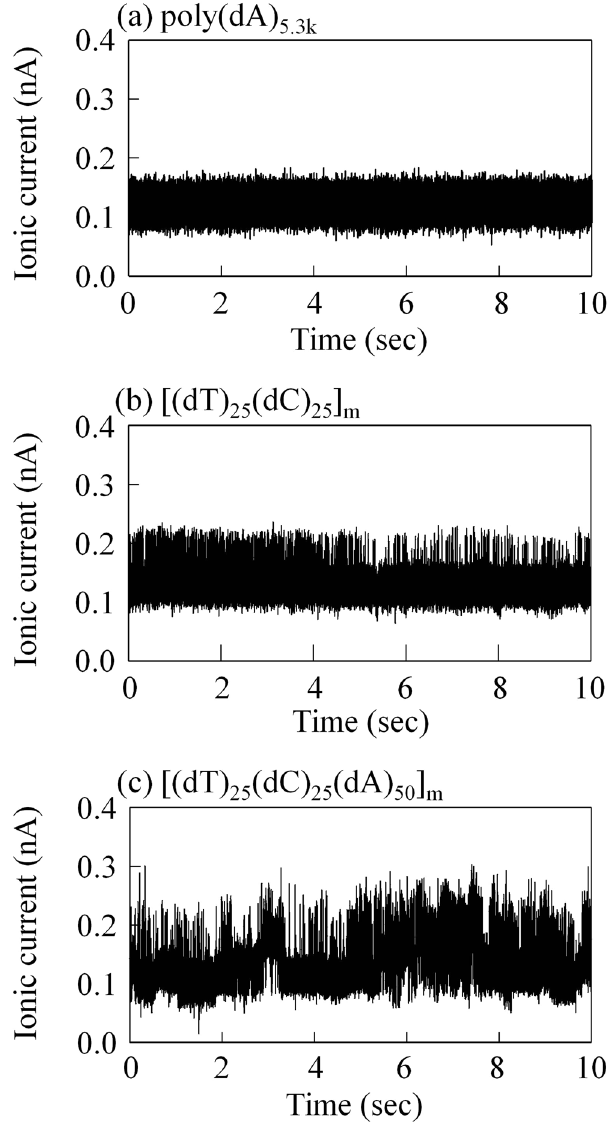
Figure 5. Long-term time trace of the ionic current while the homopolymer or block copolymer remained in the nanopore. A typical time trace of the ionic current for 10 sec while ( a ) poly(dA) 5.3k , ( b ) [(dT) 25 -(dC) 25 )] m , and ( c ) [(dT) 25 -(dC) 25 -(dA) 50 ] m remained in the nanopore. Each applied voltage was 100 mV. Each current signal was filtered at 5 kHz. The diameter of each nanopore was ( a ) 2.07 nm, ( b ) 1.93 nm, and ( c ) 2.08